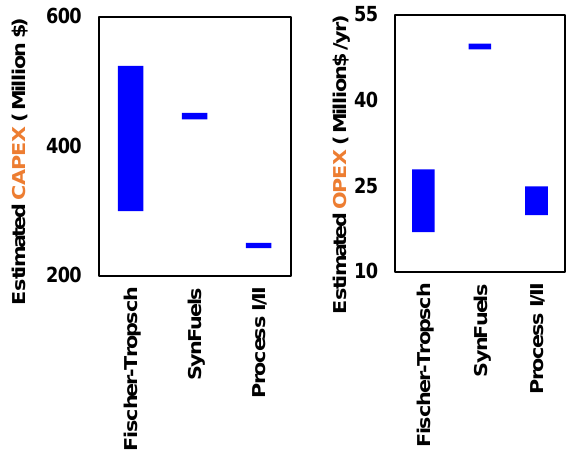
Figure 6. Comparison of total capital and operating costs from this study with the capital and operating costs of other existing